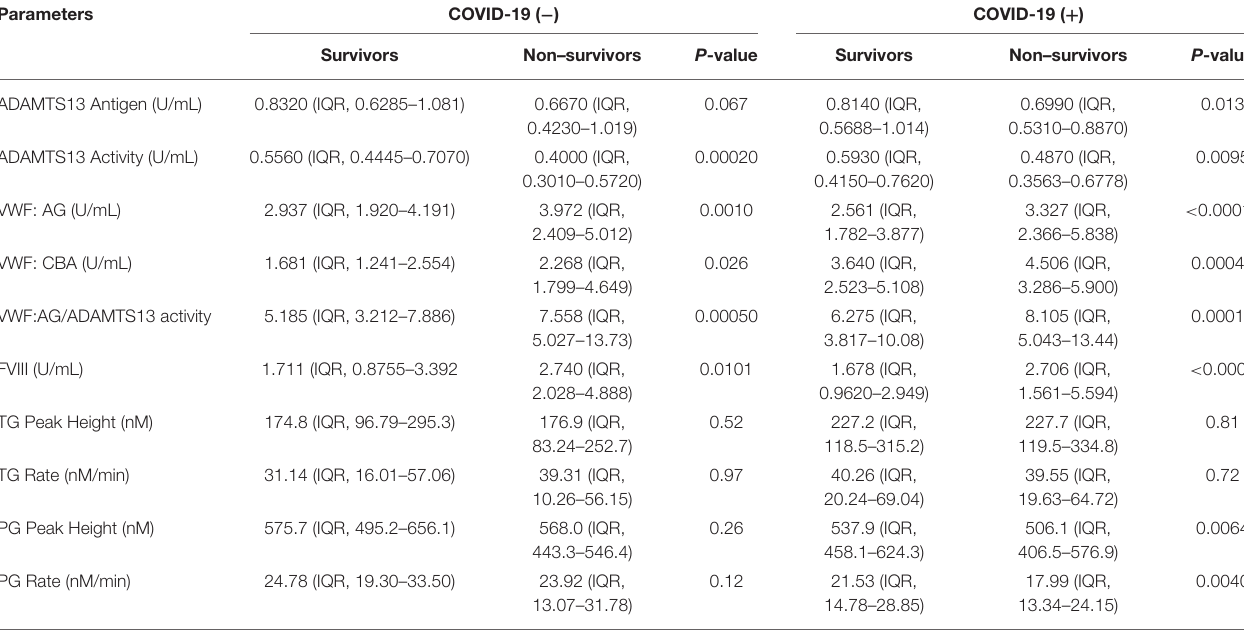
TABLE 4 | VWF, ADAMTS13, thrombin generation, and plasmin generation characteristics by survivors and non–survivors in COVID-19 positive and negative